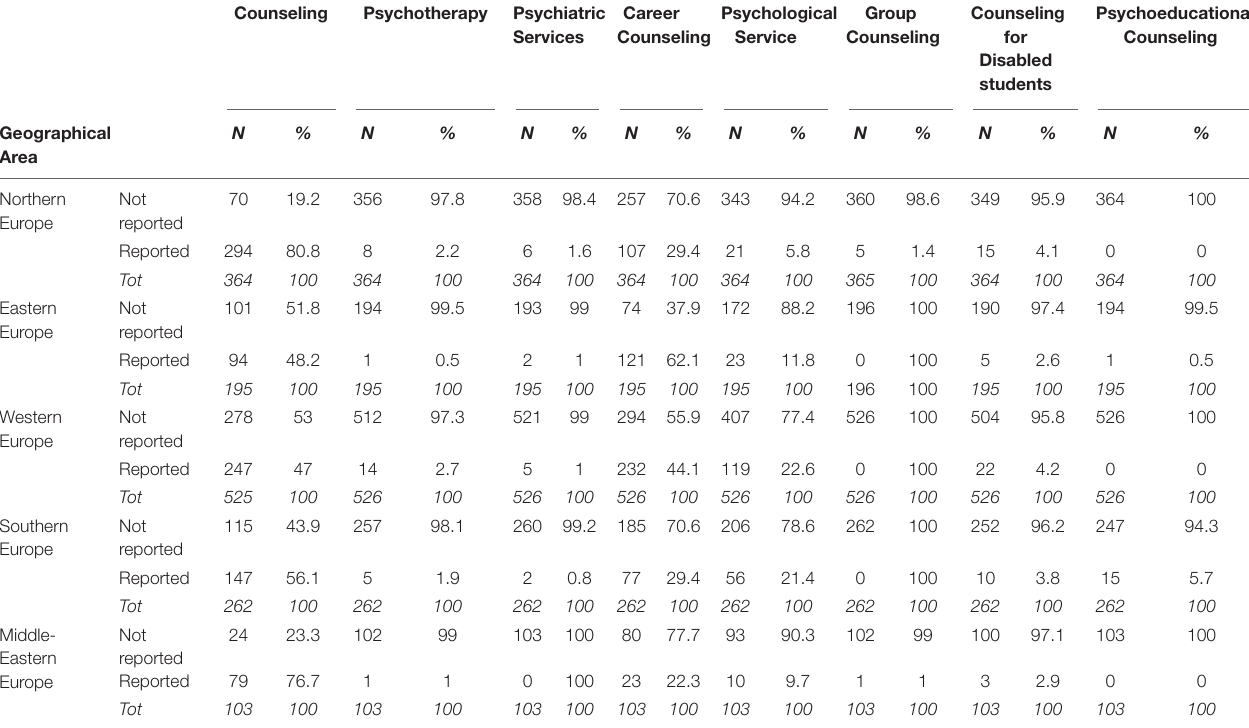
TABLE 8 | Service offered by students counseling centers in different European